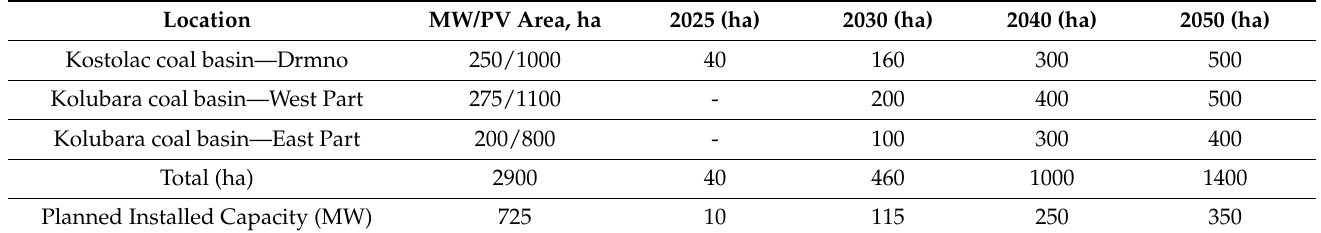
Table 1. Dynamics of using opencast mine flat surfaces